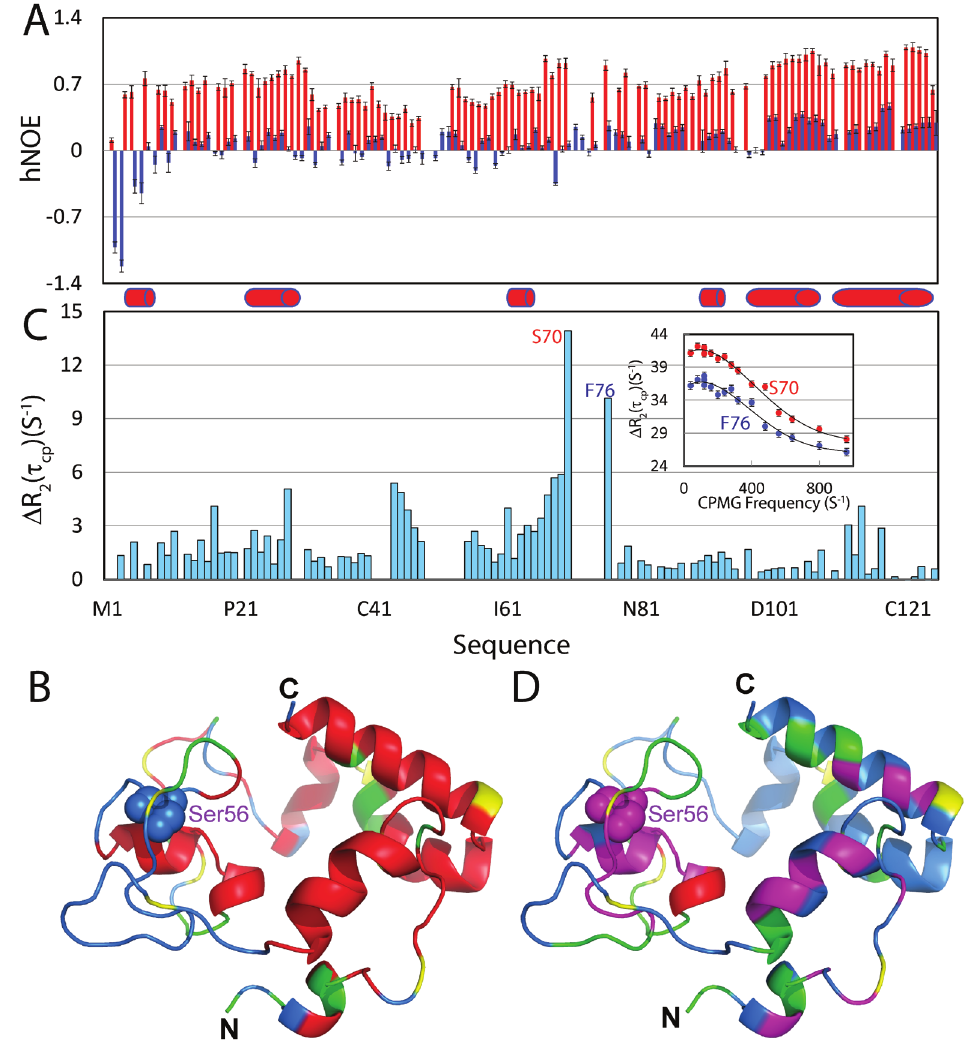
Figure 4. Backbone dynamics on the ps-ns and µs-ms time scales. A . { 1 H}– 15 N heteronuclear steady-state NOE (hNOE) of the P56S MSP in aqueous solution (blue) and in a DPC micelle (red). B . Structure of the P56S MSP in DPC micelles, with Pro residues colored in yellow; missing or overlapped residues in green and residues with hNOEs > the average in red. C . Difference of effective transverse relaxation rate R ( τ ) at 80 and 960 Hz. Inlet: dispersion curves for two residues S70 and F76. Red cylinders are used to indicate helices formed in DPC 2 cp micelles. D . Structure of the P56S MSP in a DPC micelle, with Pro residues colored in yellow; residues missing or with data having large noise in green; and residues with Δ R ( τ ) > 2 in pink and residues with Δ R ( τ ) > 6 in red. 2 cp 2 cp time scale, the existence of significant µs-ms motions in the